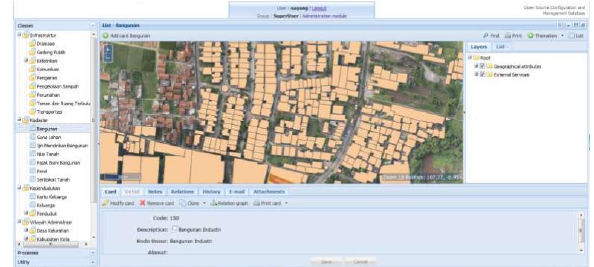
Figure 7. CMD Build for private user of village